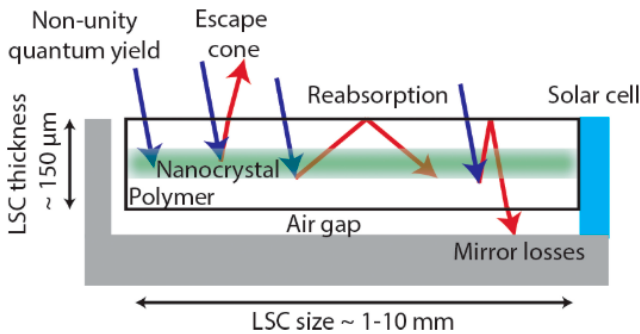
Figure 14. Scheme showing the energy loss pathways in a luminescent solar concentrator. Reproduced with permission from [172]. Copyright American Chemical Society, 2016.